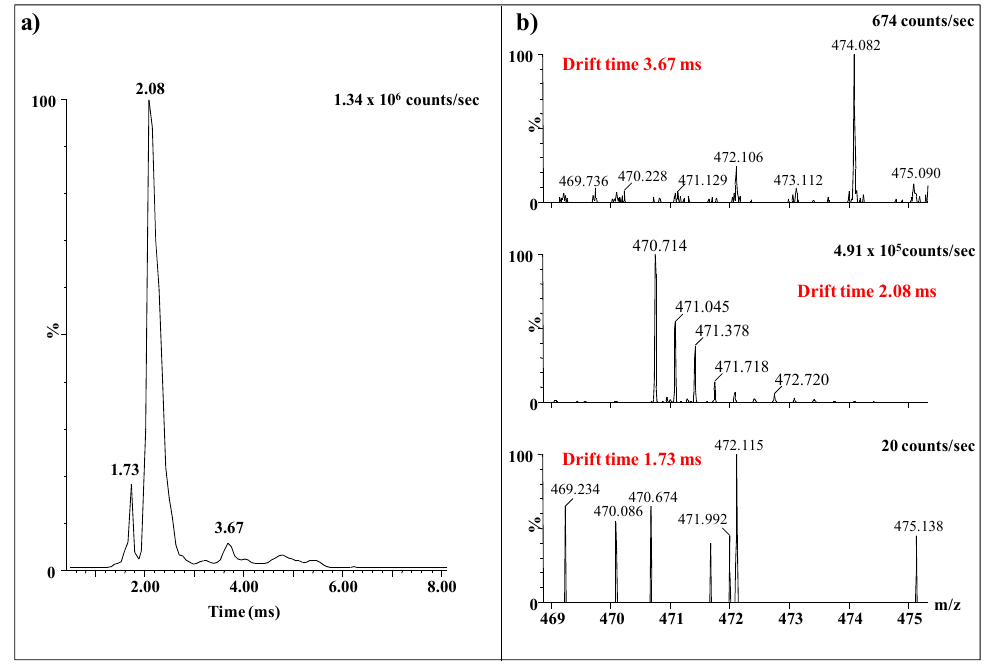
Figure 6. IMS MS of the precursor ion at m/z 470.714 fragmented by CID: ( a ) drift time distribution; ( b ) extracted mass spectra at the three mobility features: 3.67 ms, 2.08 ms, and 1.73 ms. The IMS CID MS/MS of the ion at m/z 470.714 is presented in Figure 7 whereas the fragment ions together with their assignment are listed in Table 2.